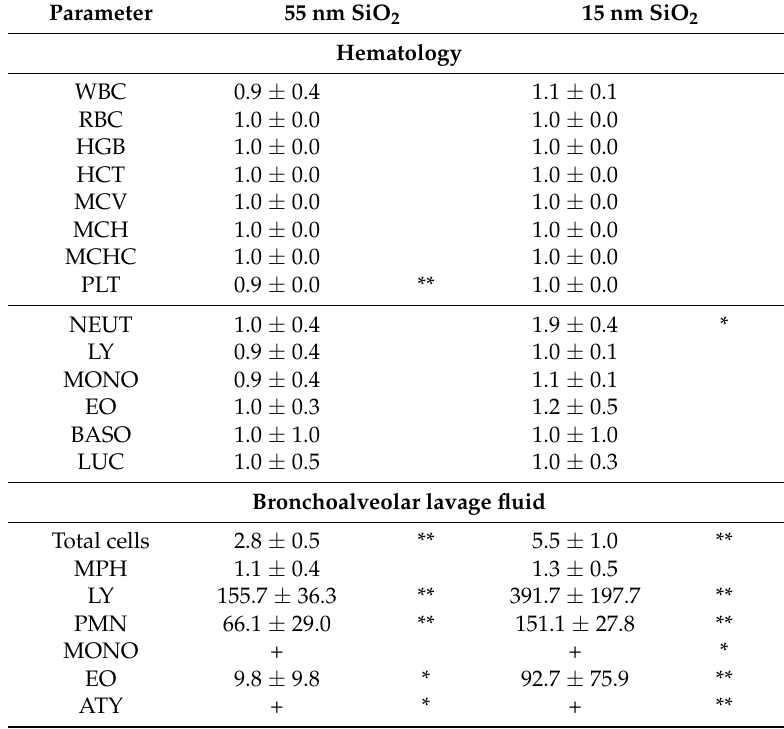
Table 5. In vivo rat intratracheal instillation study assessing 55 nm and 15 nm SiO 2 : hematology and bronchoalveolar lavage fluid parameters (five animals per